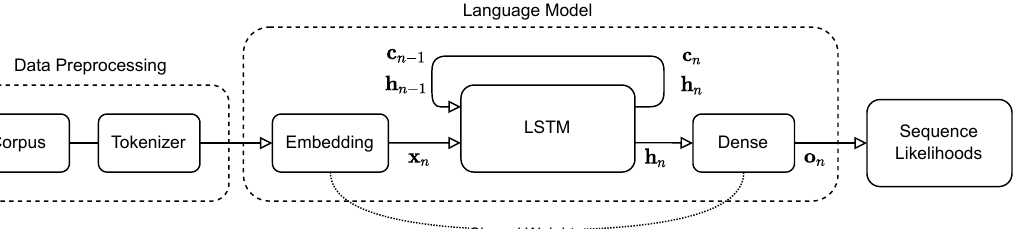
Figure 1. Structure of the LSTM language model. Each batch of the respective training corpus is first preprocessed and tokenized, and then presented as input to the embedding layer, which computes the embedded vector x n . This embedded vector is presented as input to the LSTM network along with the hidden ( h n − 1 ) and cell state ( c n − 1 ) vectors. The updated hidden state vector is presented to the output dense layer, whose weights are shared with the embedding layer, to form a likelihood vector of the next possible words ( o n ). This process is repeated for each token in the current sequence. L2 weight regularisation is specifically applied to the weight-tied embedding and dense layer, as well as the recurrent kernel in the